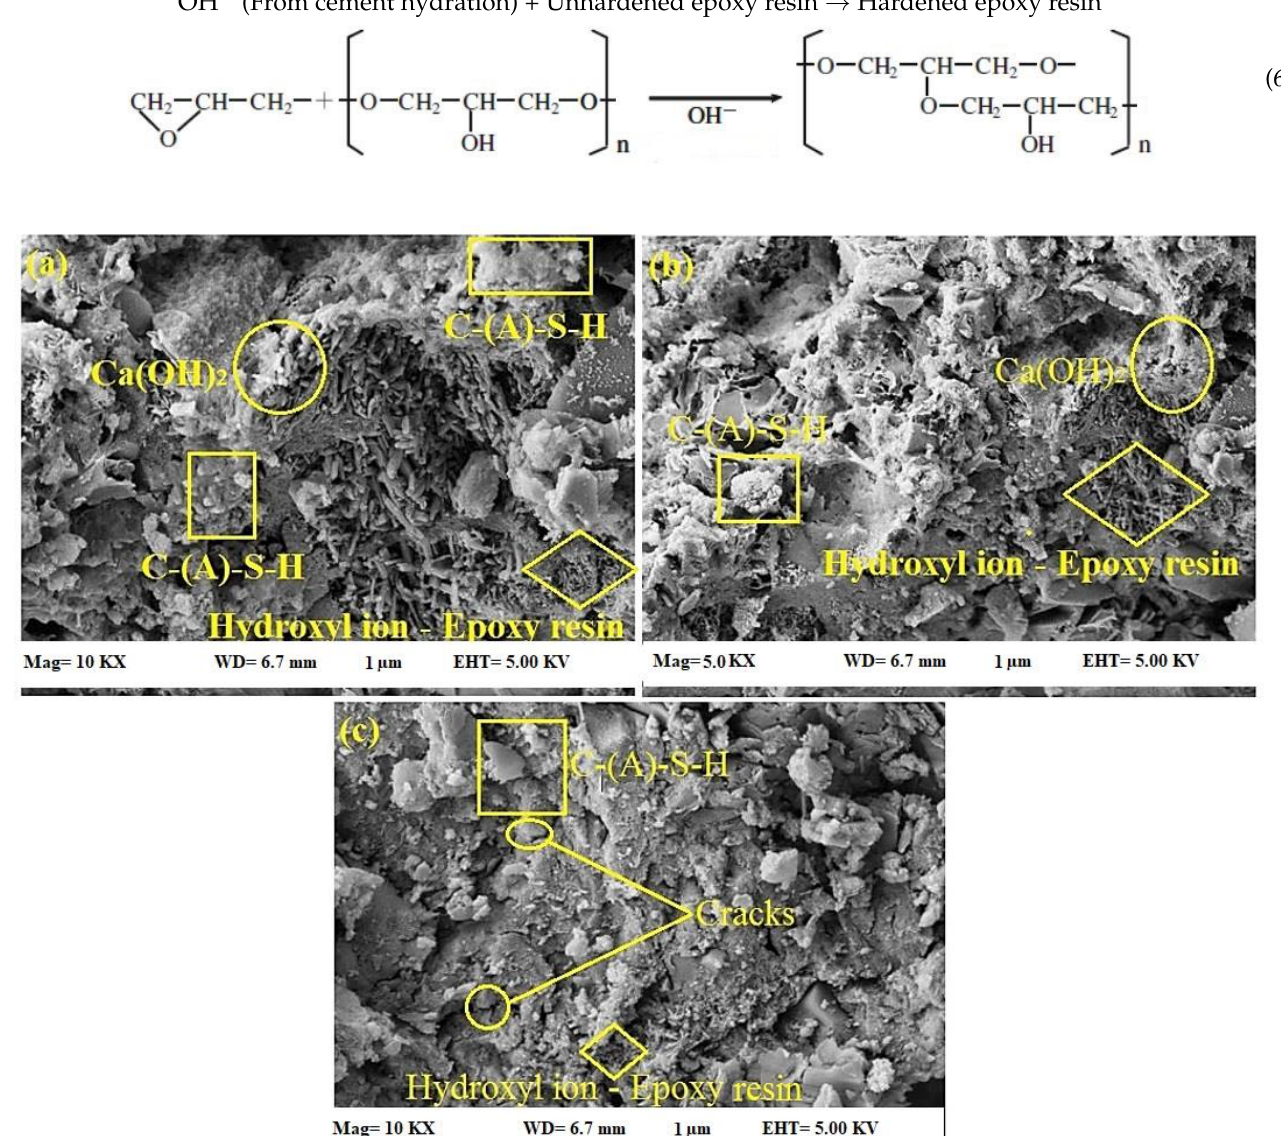
Figure 15. SEM morphology of self-healing mechanism of epoxy-modified specimen after artificial cracks generation ( a ) 28 days ( b ) 180 days ( c ) 365 days of curing age.